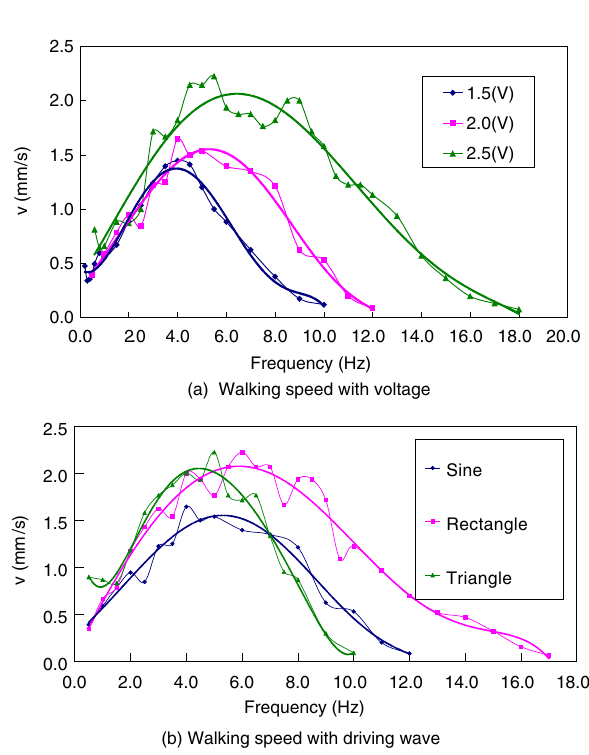
Figure 18 Experimental results of the micro-robot with two degrees of freedom. (a) Walking speed with voltage, (b) walking speed with driving